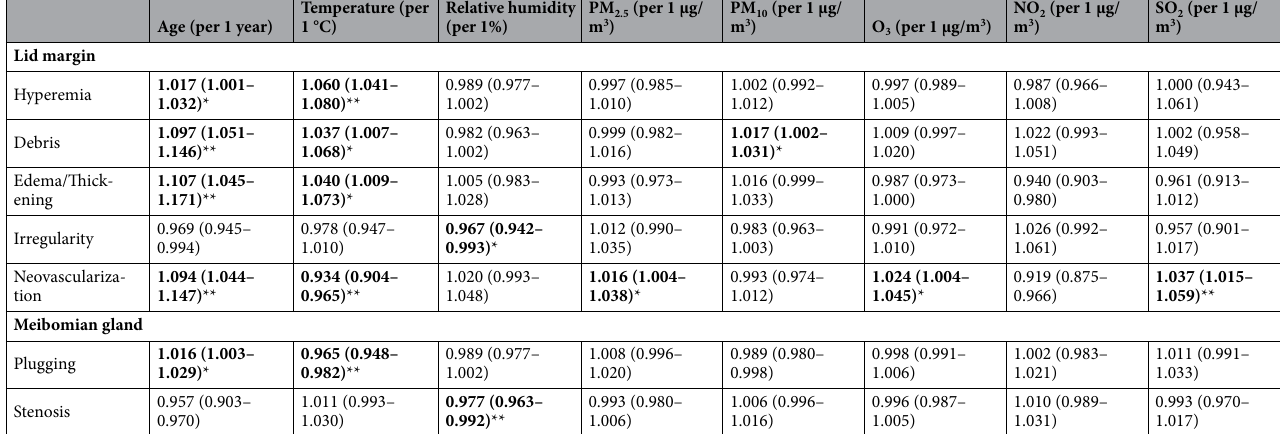
Table 2. Logistic regression: effects of air quality on meibomian gland dysfunction signs. PM particulate matter,